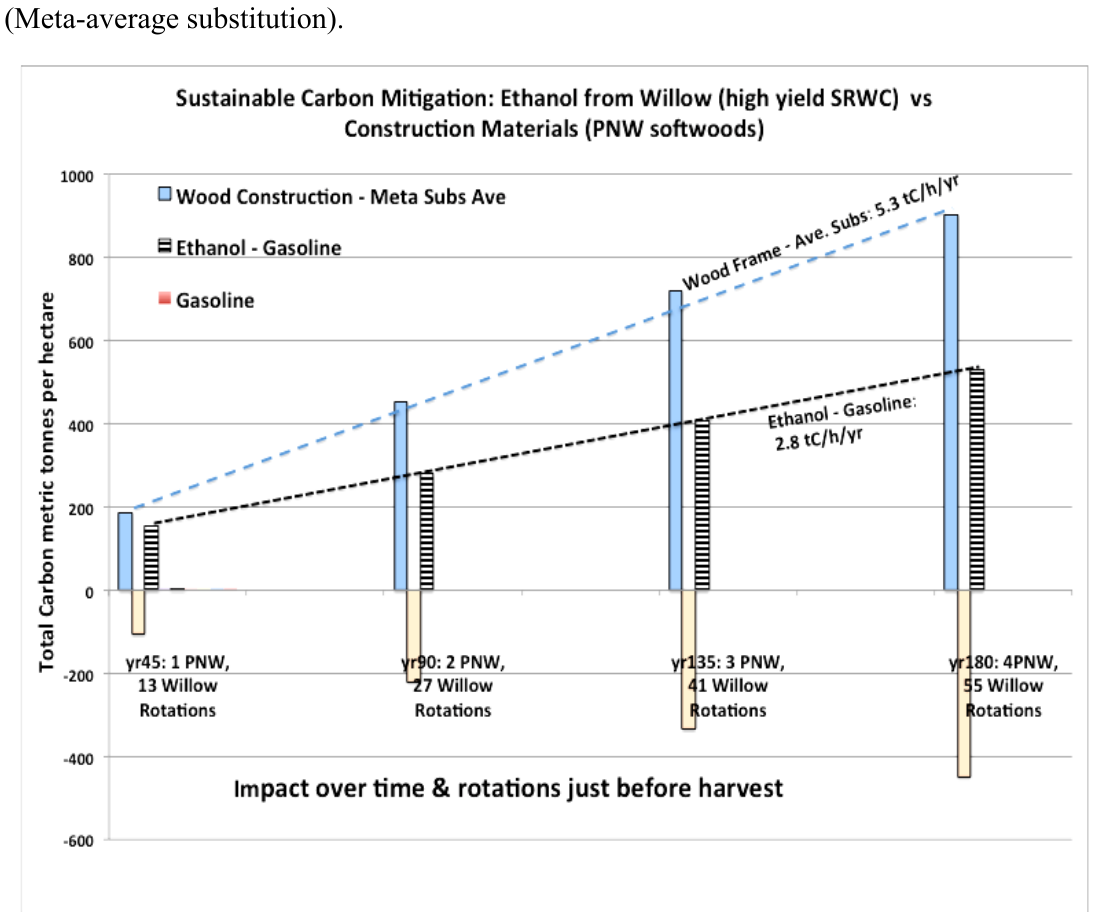
Figure 4. Total carbon mitigation potential from high yield short rotation crop of